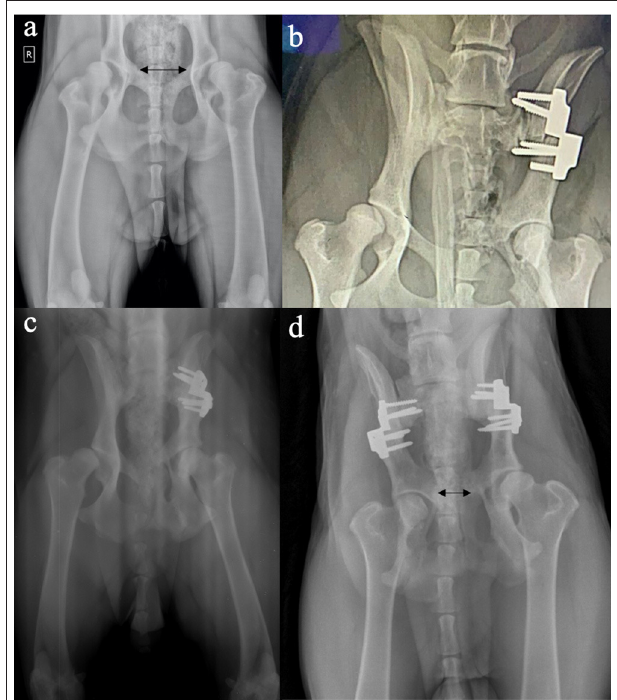
FIGURE 2 | Ventrodorsal radiographs of the hip joints before (a) , and immediately after (b) , and at 6 months (unilateral) (c) and bilateral (d) triple pelvic osteotomy. Note the improved congruence and acetabular support on the postoperative radiographs. Also note the difference in the distance between the lateral edges of the pubic osteotomies (double-headed arrows) pre- and postoperative, suggesting 40% of pelvic canal narrowing with the triple pelvic